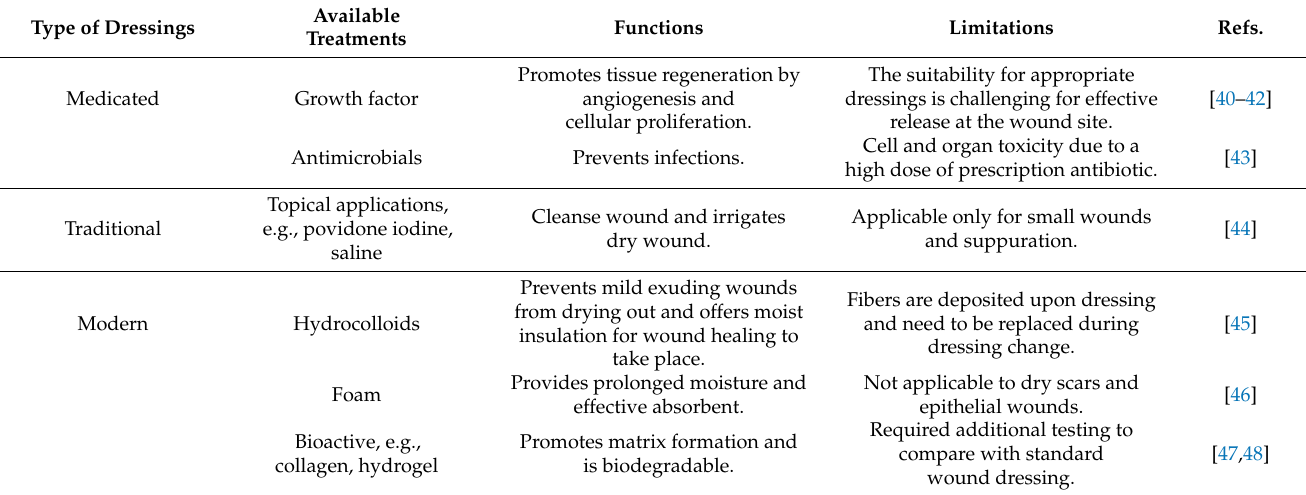
Table 1. The different types of dressings currently used to treat chronic